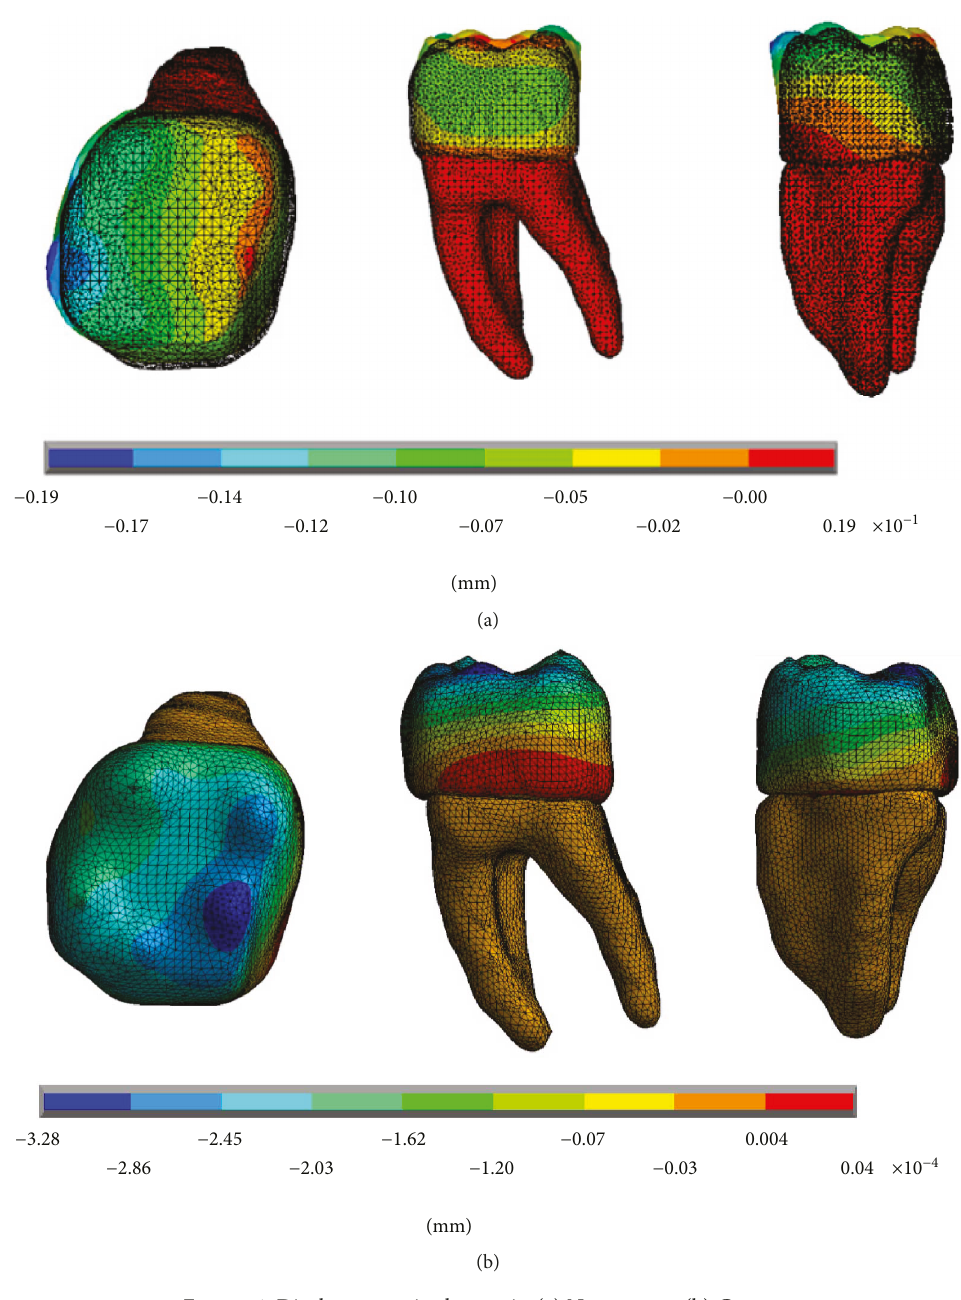
Figure 4: Displacements in the x -axis. (a) Noncontact. (b)